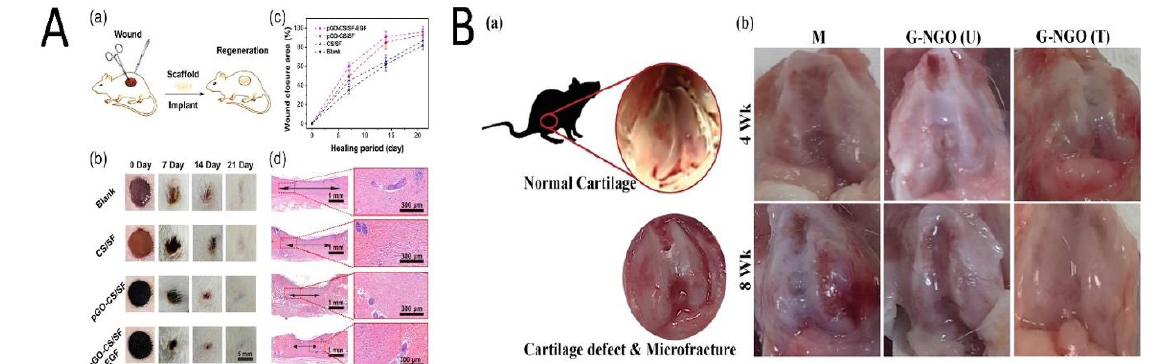
Figure 5. ( A ) Wound healing of the skin through the treatment of various scaffolds. ( a ) Model of wound regeneration. Digital images ( b ) and closure rate ( c ) of the wound defects; multiple treatments at Days 0, 7, 14, and 21. ( d ) Depictive images of H&E-stained histological sections after 21 days (arrows indicate the granulation tissue). Reused with permission from [68]. Copyright © 2021 American Chemical Society. ( B ) ( a ) A normal rat knee joint; ( b ) knee joint restoration in different experimental groups (M: without implant; GO-NGO (U): non-crosslinked hydrogel; GO-NGO (T): microplasma crosslinked hydrogel) i 4 and 8 weeks. Reused with permission from [24]. Copyright © 2021 American Chemical Society.